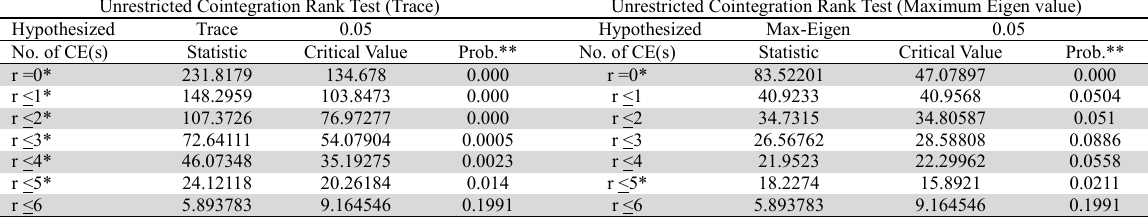
Johansen cointegration test results for USA